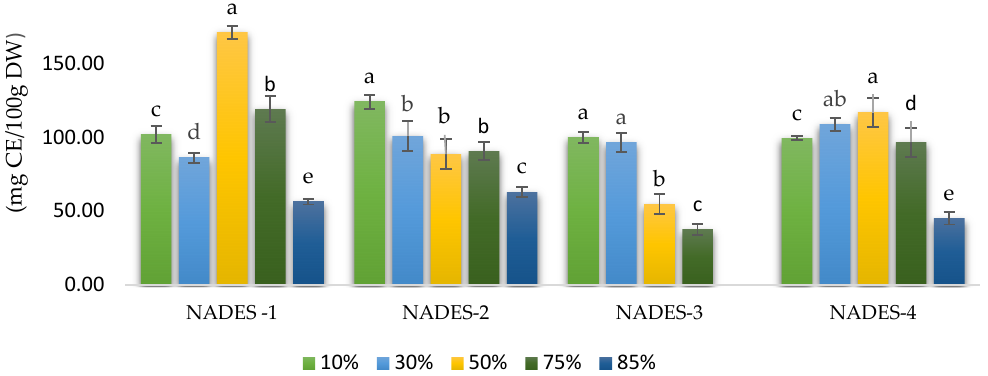
Figure 1. Total flavonoid extraction yields for natural deep eutectic solvents (NADES-1 to NADES-4) according to the percentage of NADES in water, 1:10 solid–liquid ratio and 30 min of extraction. a–e: different letters indicate that there are statistically significant differences ( p < 0.05).